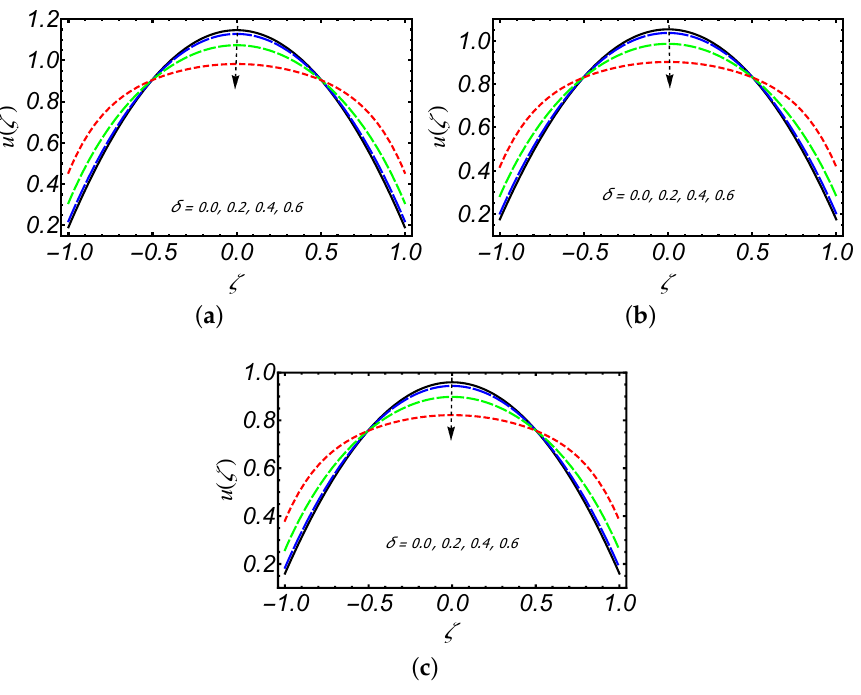
Figure 6. Behavior of u ( ζ ) with δ at ( a ) x = 0.1, ( b ) x = 0.5, ( c ) x = 0.9, when K = 0.2, φ = 0.1.